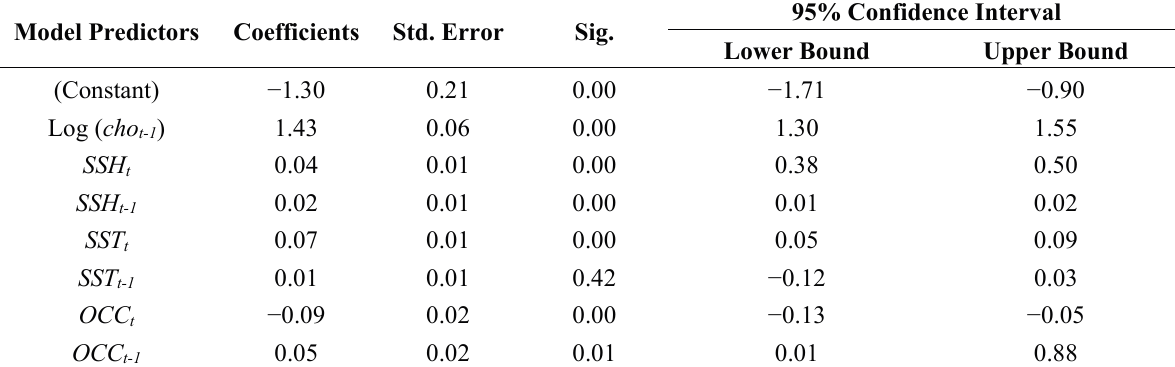
Table 3. Summary of the model obtained for the study area.